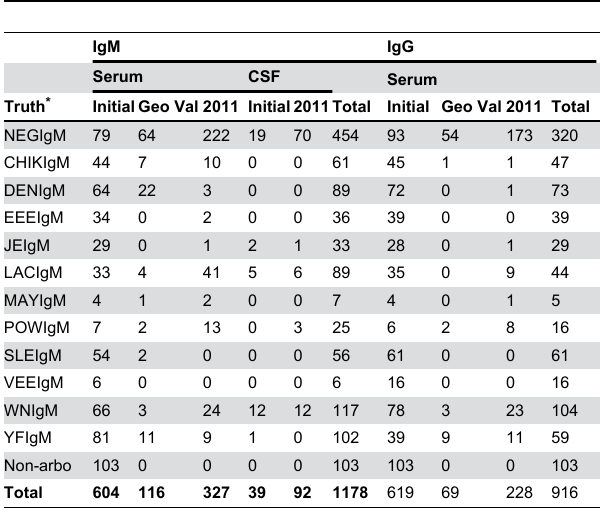
Table 1. Samples tested in the IgM and IgG multiplex MIAs listed by virus.